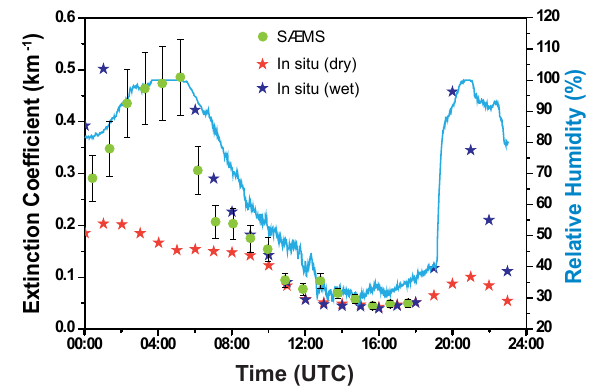
Fig. 8. Time series of the extinction coefficient on 3 May 2009 at 550nm (SÆMS, green circles) in comparison to extinction coeffi- cients calculated from in situ aerosol observations on the roof of the TROPOS building. Red stars are computed from in situ-measured dry particle size distribution, and blue stars are computed from the in situ observations after applying a particle-water-uptake correc- tion. A strong correlation of particle extinction and relative humid- ity (light-blue line) is